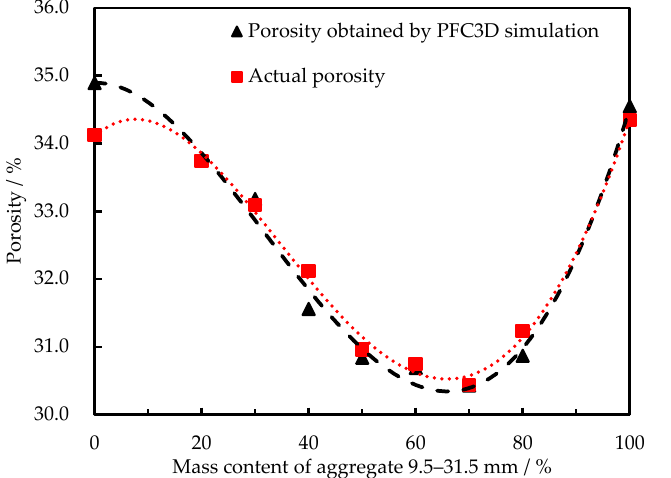
Figure 9. Fitting results of void ratio of 9.5–31.5 mm aggregate and 4.75–9.5 mm aggregate in different mass ratios.